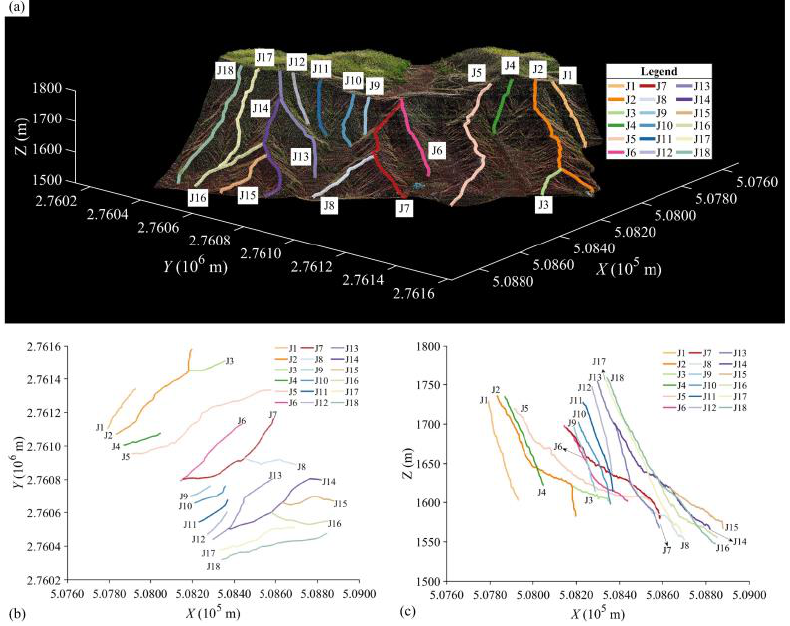
Figure 12. ( a ) The ridge lines combined with point-cloud display, ( b ) the ridge lines’ XY projection, and ( c ) the ridge lines’ XZ projection. Table 5. Measurement results of ridge lines’ morphological